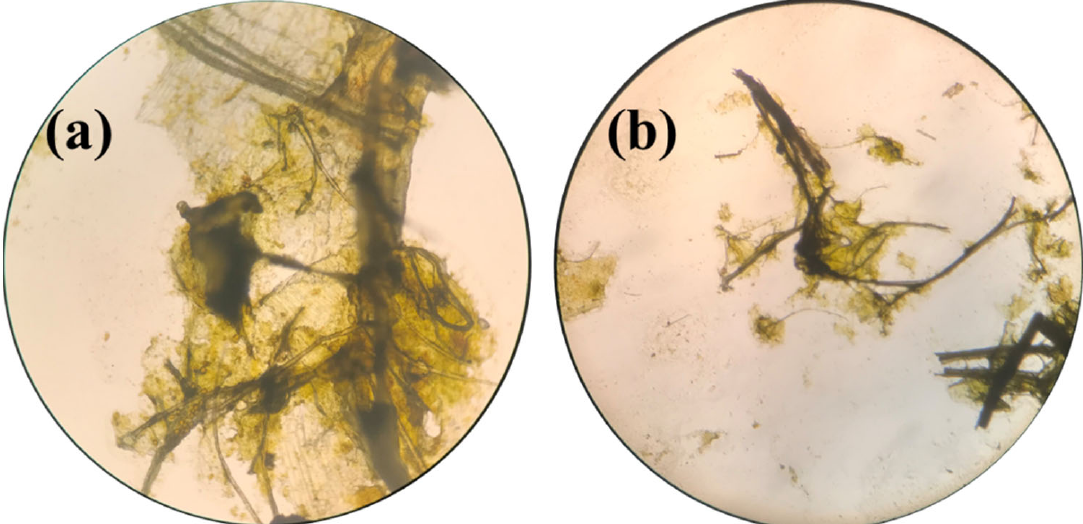
Figure 12. Microscopic image of ( a ) Fe(III)-rhamnoxylan in stomach after 24 h and ( b ) stomach material after 14 days.